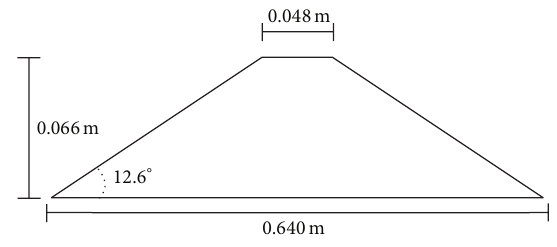
Figure 2: Island dimensions